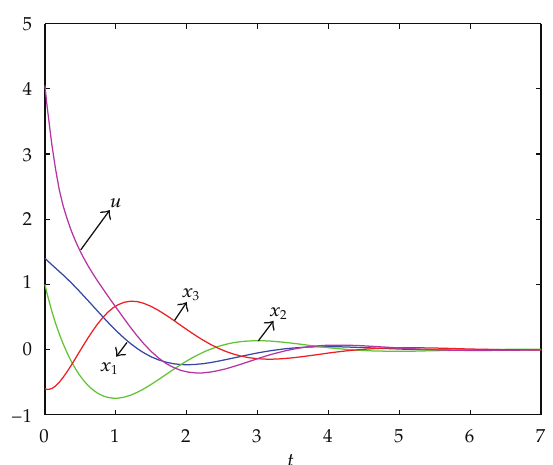
Figure 4: The control law and time response of the controlled system (cid:2) 4.10 (cid:3)